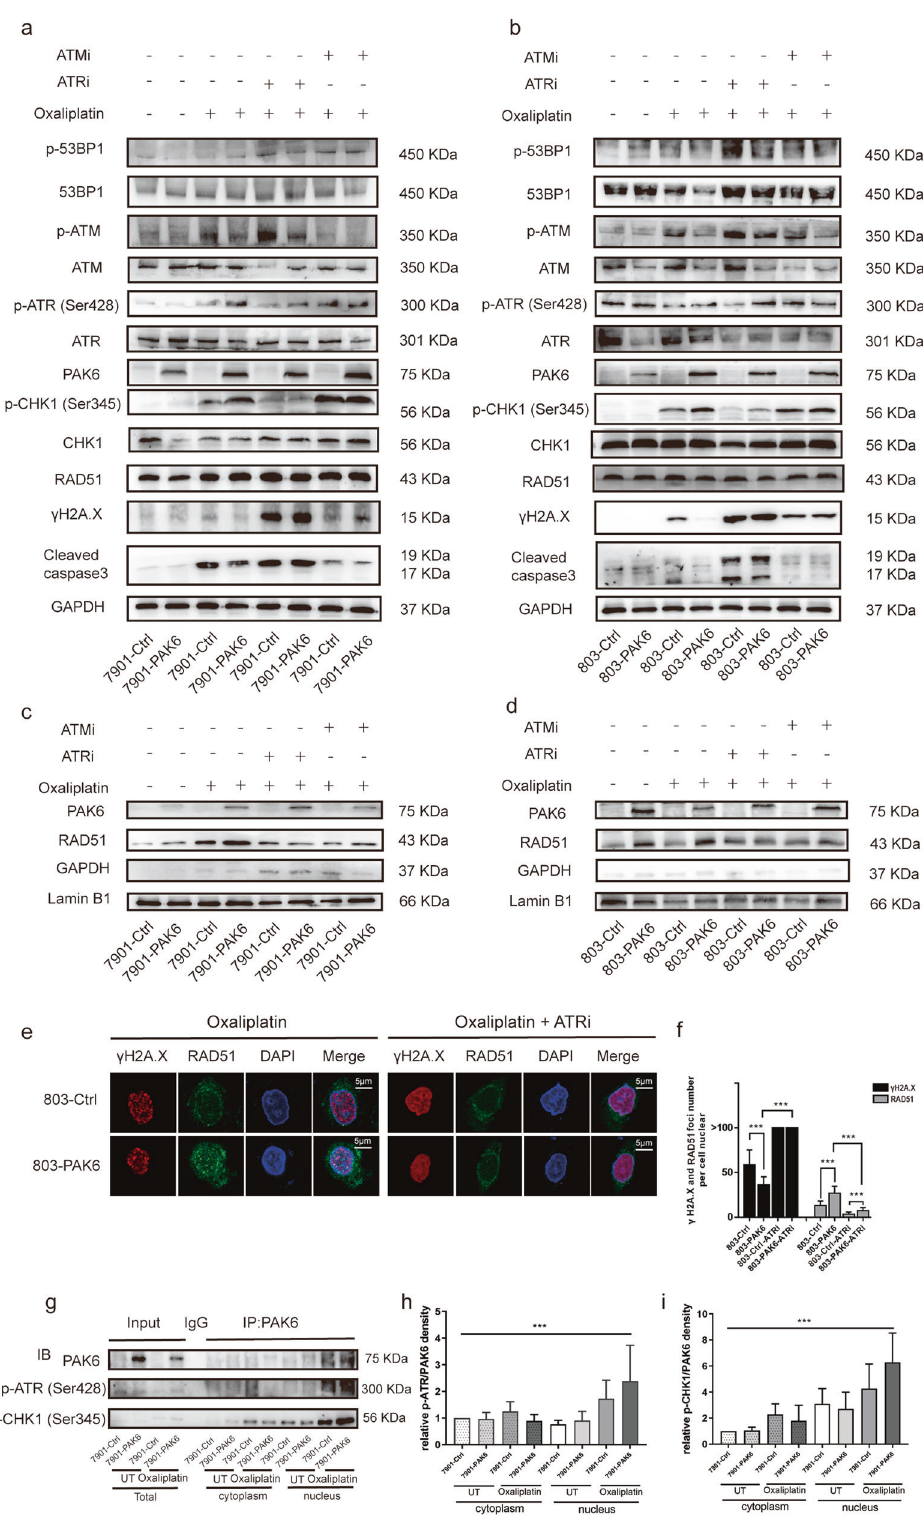
associate with chemoresistance to oxaliplatin but not 5-FU. It was evident that chemosensitivity was increased after PAK6 knockdown but strongly decreased after PAK6 overexpression. Functional experiments demonstrated PAK6 can facilitate HR repair